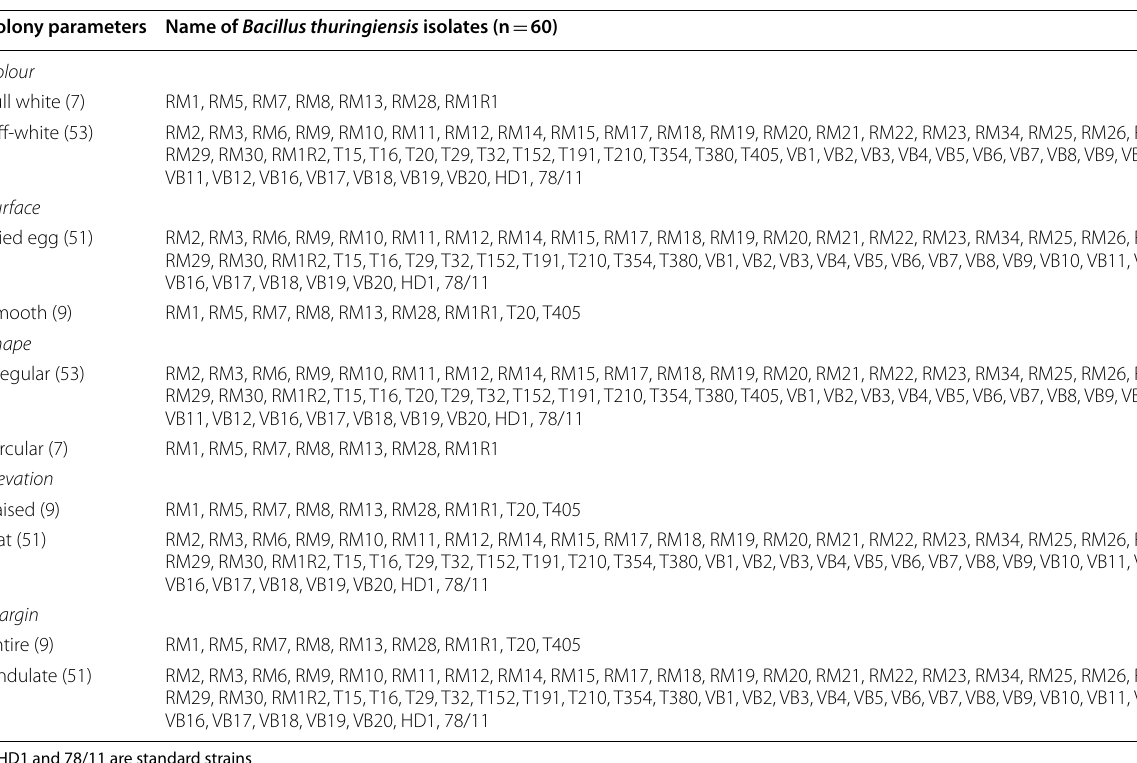
Table 1 Colony morphology of indigenous Bacillus thuringiensis isolates Colony parameters Name of Bacillus thuringiensis isolates (n